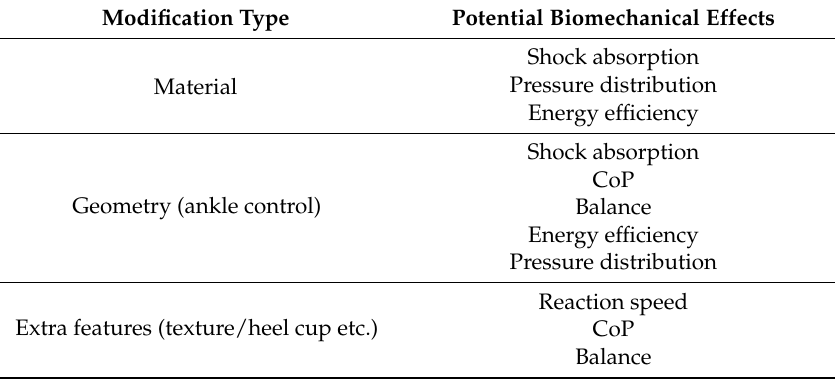
Table 1. Shoe-insole modification and biomechanical effects